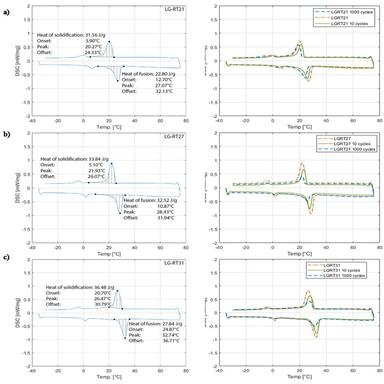
0-10-1000 cycles and subcooling with peaks of a) LG-RT21 b) LG-RT27 c) LG-RT31.